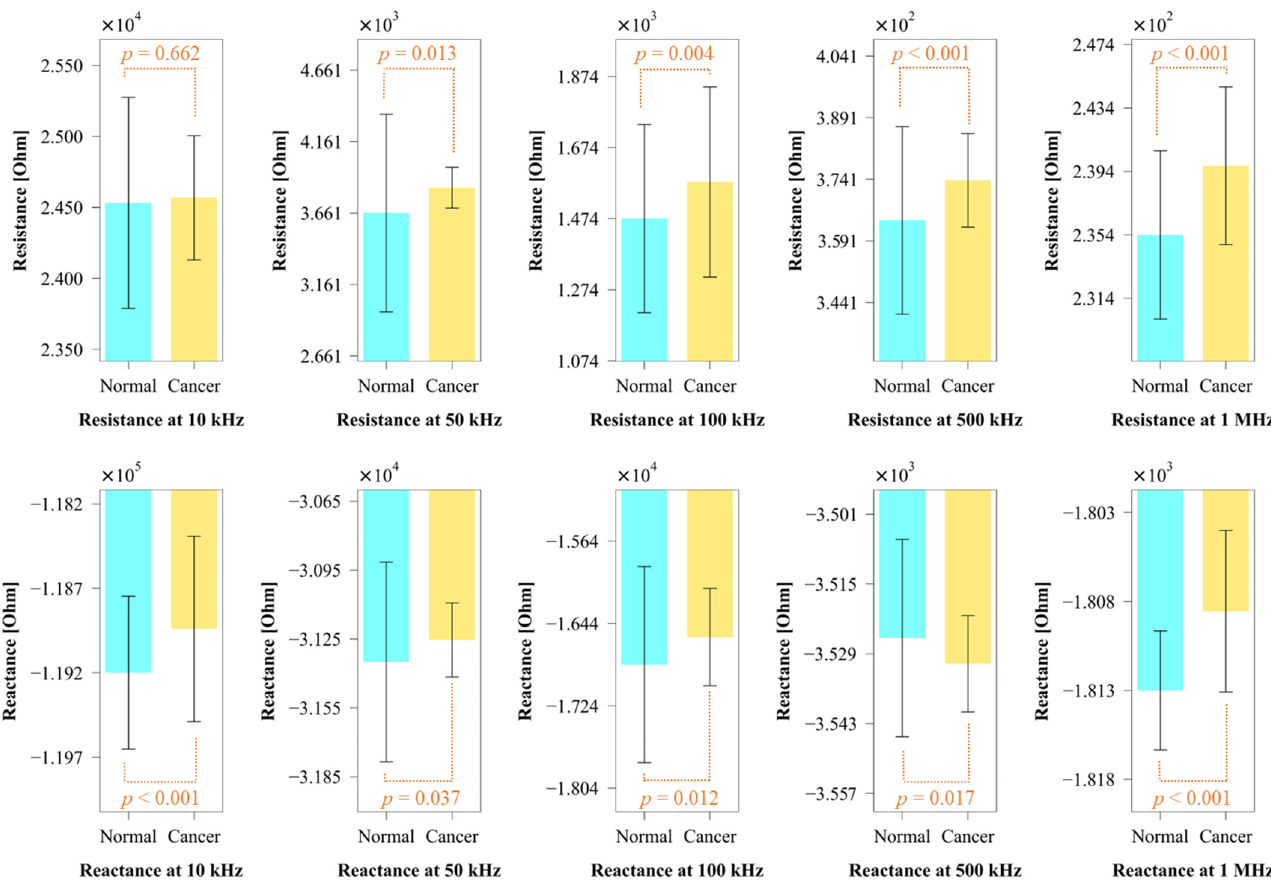
Figure 5. Impedance comparison between SV-HUC-1 and TCCSUP cells at each frequency. The blue and yellow bars represent the SV-HUC-1 and TCCSUP cells, respectively. The vertical error bars show standard deviation. All the impedance differences are statistically significant ( p < 0.05), apart from the resistance at 10 kHz.